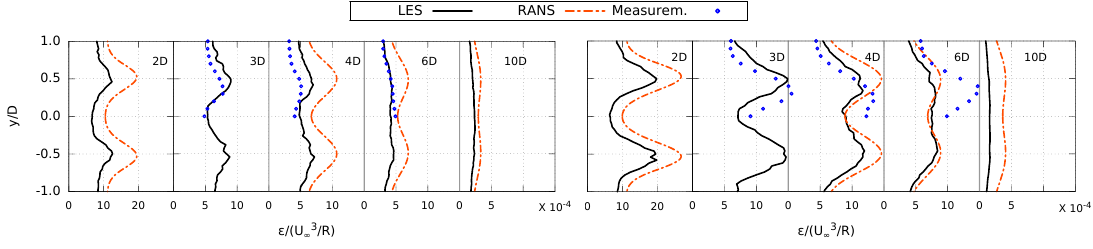
Figure 10. Vertical profiles of ε behind the disk C T = 0.45 ( left ) and C T = 0.71 ( right ), Ti12 case. The scale for the curves at x = 2 D has been doubled to accommodate the larger